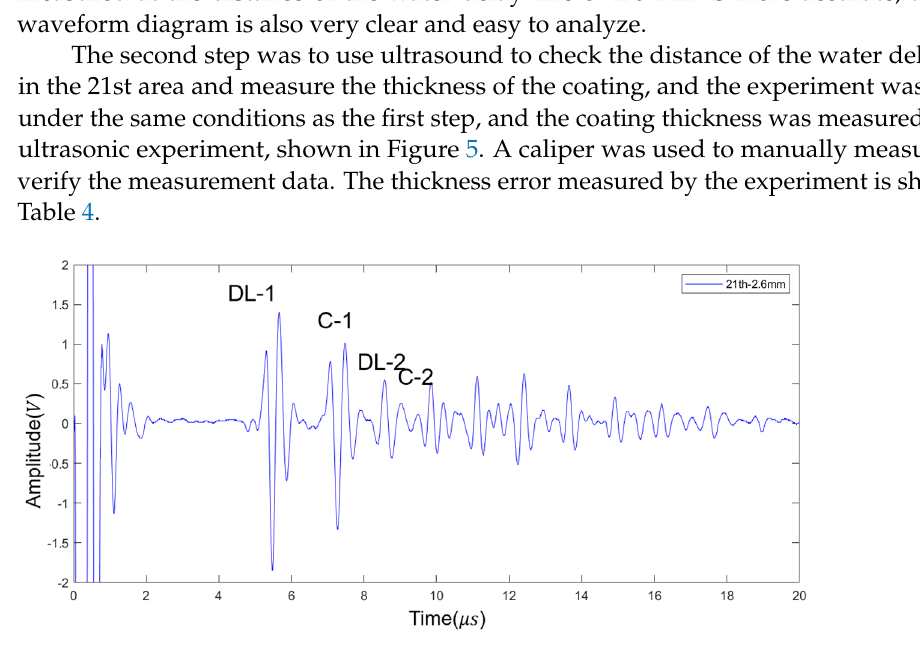
Figure 5. Experiment results. The 21st area coating material thickness measured: Water delay line 2.6 mm